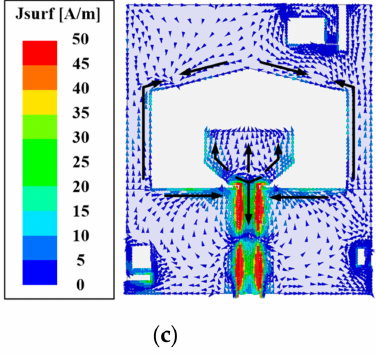
Figure 4. Simulated surface current distributions of the proposed antenna for spectrum sensing mode (P1 ON): ( a ) low frequency at 3.1 GHz, ( b ) mid frequency at 6.52 GHz, and ( c ) high frequency at 9.5 GHz.